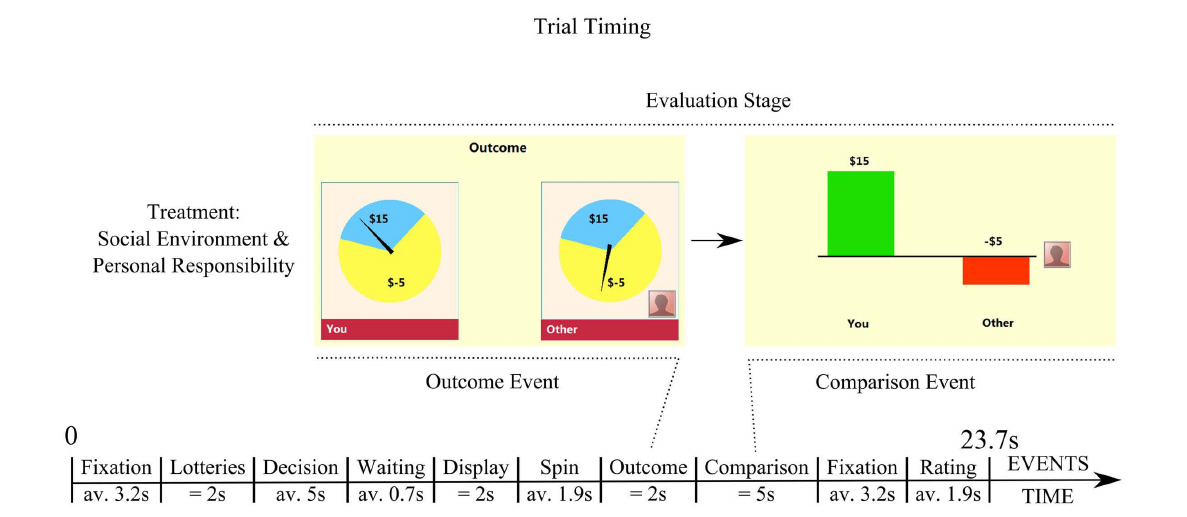
FIGURE 1 |Trial timing with duration and sequence of events. The study focuses on ex post evaluation stage that is divided into two events: outcome event and comparison event.The events presented in this Figure refer to the treatment of social environment and personal responsibility. At comparison